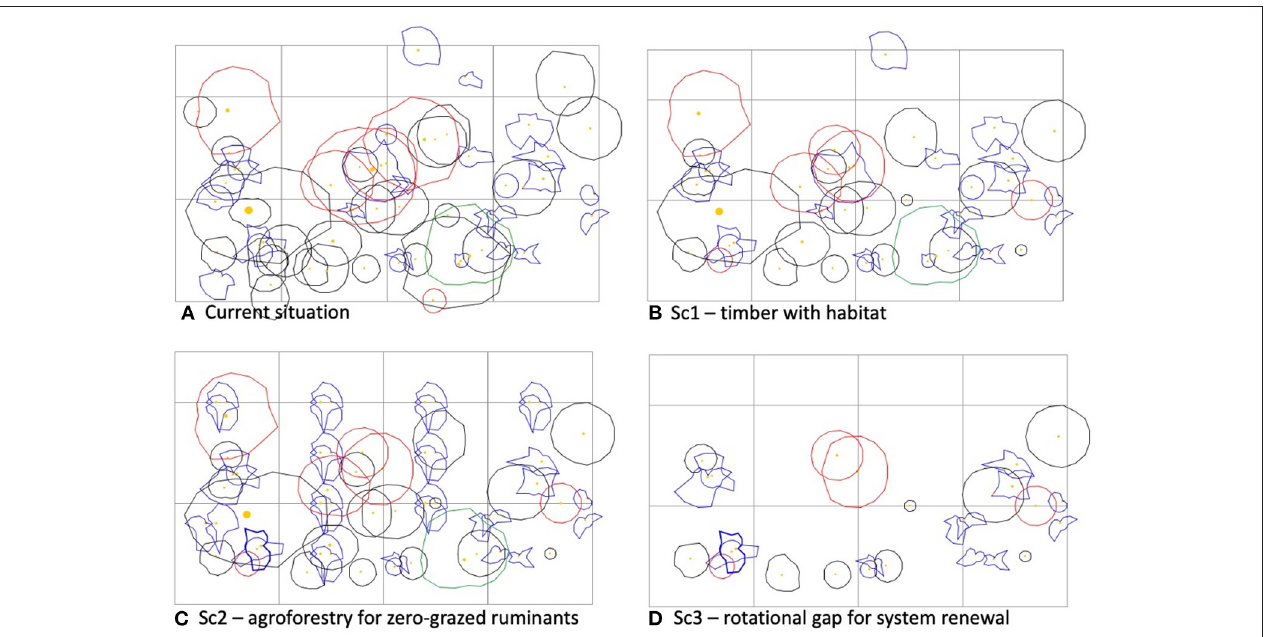
FIGURE 6 | Changes in canopy coverage and distribution for the current plot and three different scenarios for the MIX plot case. Four canopy components are graphed—banana (blue), Inga (green), timber trees (red), and other trees (black). (A) Current situation. (B) Sc1—timber with habitat. (C) Sc2—agroforestry for zero-grazed ruminants. (D) Sc3—rotational gap for system